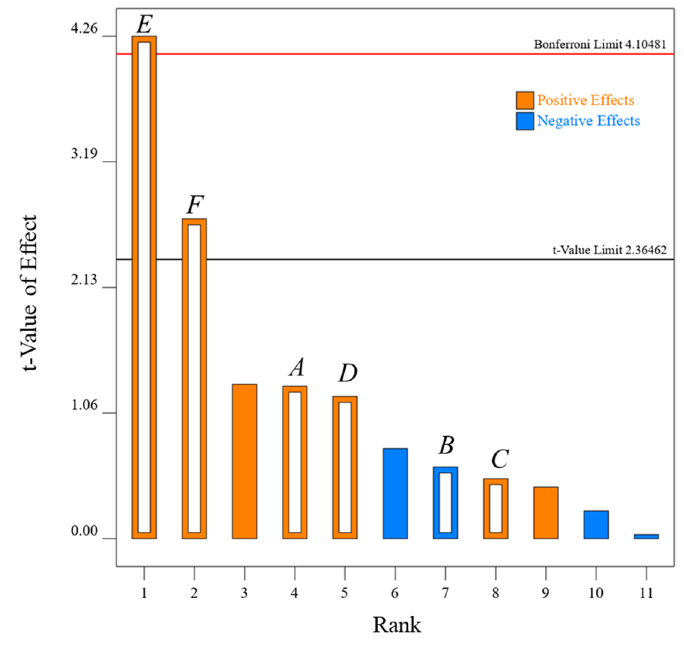
Figure 10. Pareto Figure 10. Pareto charts.